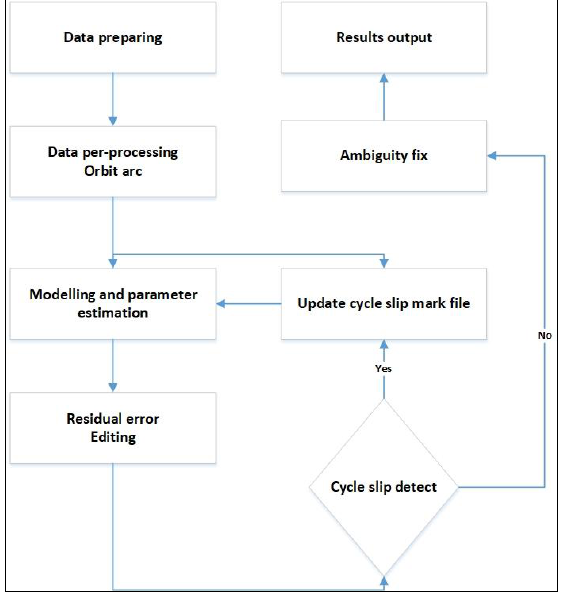
Figure 1 . Data processing modules.